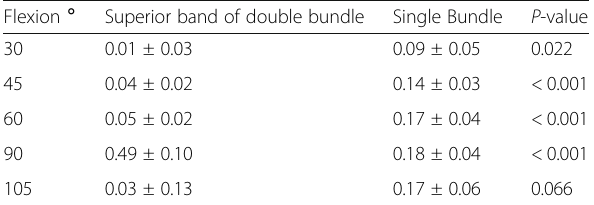
Table 3 Strain in superior band of double bundle versus single bundle MPFL reconstruction ( n = 6) Flexion ° Superior band of double